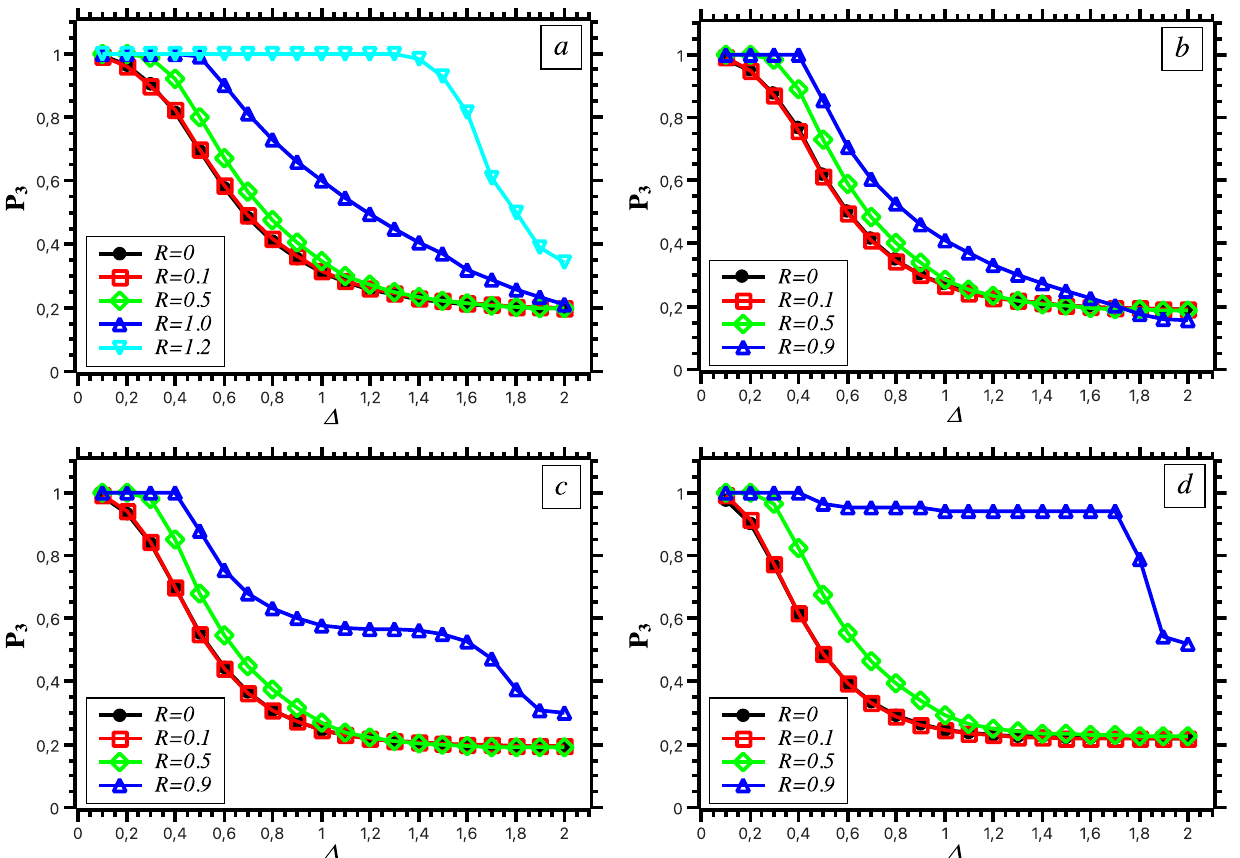
Fig. 2 The degree of alignment P 3 for the three points as a function of the disbalance Δ at the different values of the threshold R for a square ( a ) and for an ellipse with the different eccentricities e = 0 ( b ), e = 0 . 2 ( c ) and e = 0 . 5 ( d